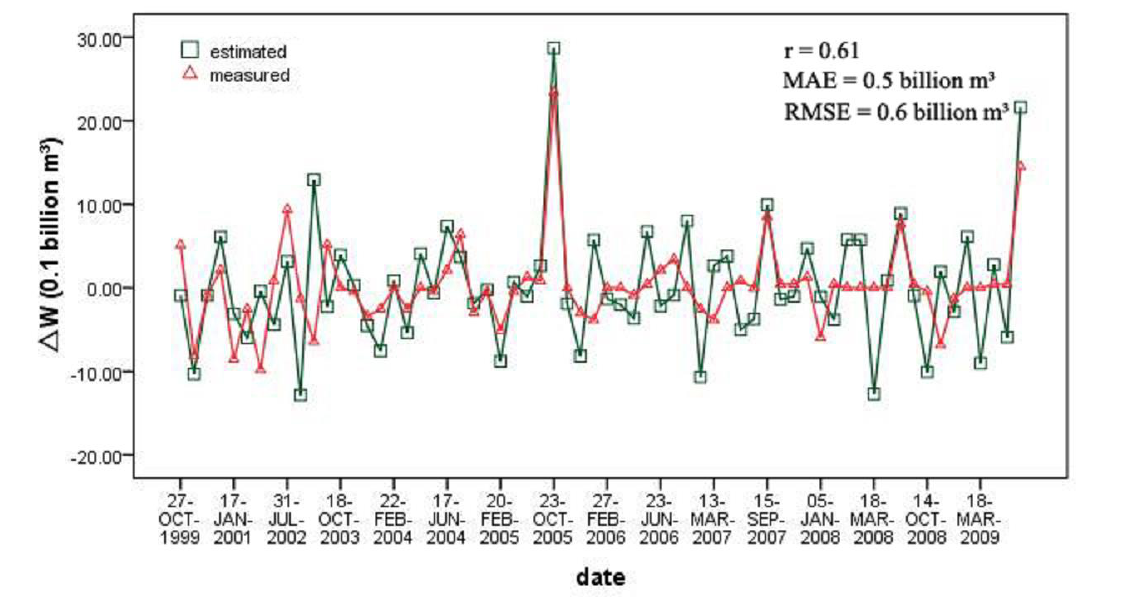
Figure 9. Comparison of the estimated water volume variations with measurements. The green square represents the water volume variations estimated by using Equation (5) and the reconstructed water level in Figure 8 as inputs. The red triangle represents the water volume variations observed at the Xiashe station, which was retrieved from the water level observations and the L-V curve provided by the Hydrology and Water Resources Survey Bureau of Qinghai